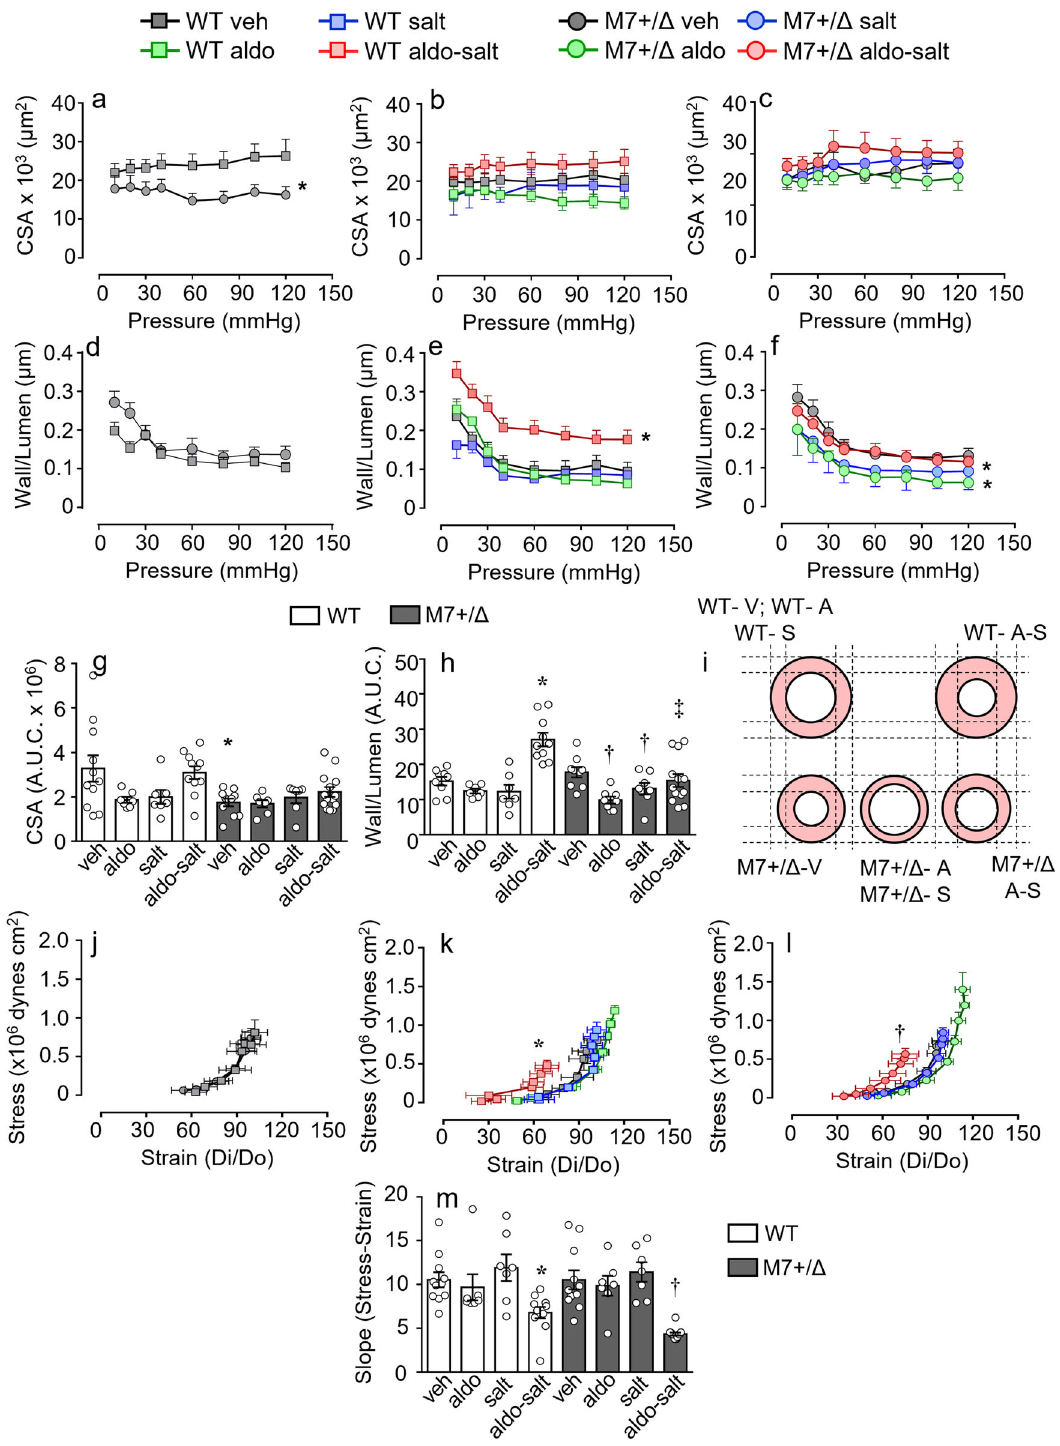
Fig. 3 Vascular remodeling and mechanical properties in WT and TRPM7 + / Δ kinase mice. Animals WT (squares) and TRPM7 + / Δ kinase (M7 + / Δ ) (circles) were treated with aldosterone (aldo, green), high salt (salt, blue) or aldosterone-salt (aldo-salt, red). Vascular structure and mechanical properties were assessed in pressurized mesenteric arteries at increasing intraluminal pressure (10 – 120 mmHg) in calcium-free conditions. a – c , g cross-sectional area (CSA); d – f , h wall to lumen ratio; i schematic fi gure of the changes in vascular structure. Mechanical properties are presented as j – l vascular stress – strain curves and m slope of the curves. N numbers: WT (veh = 11; aldo = 7; salt = 7; aldo-salt = 11), M7 + / Δ (veh = 11; aldo = 7; salt = 7; aldo-salt = 14) Data are present as mean ± SEM of Area under the curve (A.U.C.) of WT (white bars) and M7 + / Δ (gray bars). One-way ANOVA followed by Dunnett ’ s multiple comparisons test were used for statistical analysis ( a – h ). Differences in vascular mechanics were assessed using values of slope of sress – strain curves j – l that were analized using one-way ANOVA followed by Dunnett ’ s multiple comparisons test ( m ). * P < 0.05 vs WT veh; † p < 0.05 vs M7 + / Δ veh. ‡ M7 + / Δ aldo-salt vs WT